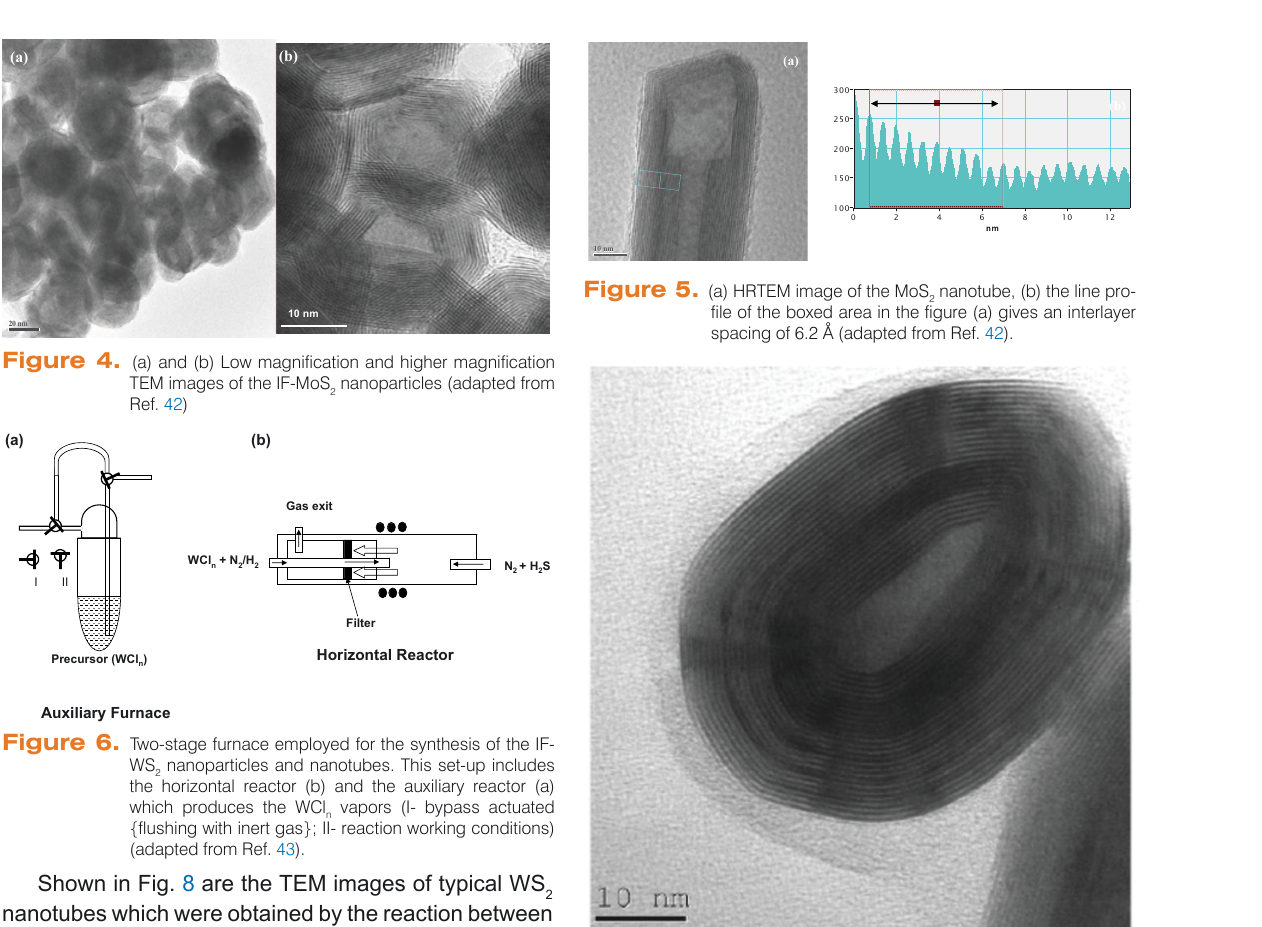
obtained from the reaction of WO zontal reactor (adapted from Ref. 43).